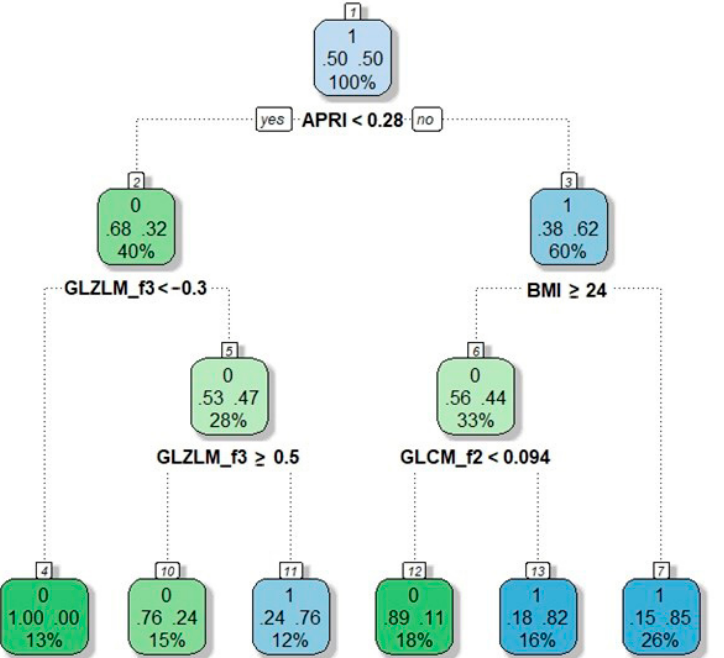
Figure 4. Decision tree for the prediction of NRH (based on model in Table 4). Nodes correspond to the decision steps. Each colored square reports: (a) the response mode class in the node, i.e., the predicted outcome of that node (presence of NRH =1; absence of NRH =0, the top number in the square); (b) the percentages of observations in the node belonging to the first response class (absence of NRH) and the second response class (presence of NRH) (the two central numbers in the square, summing up to 1); (c) the percentage of the total population falling into the node (the bottom number in the square). Decision rules are specified on each node.